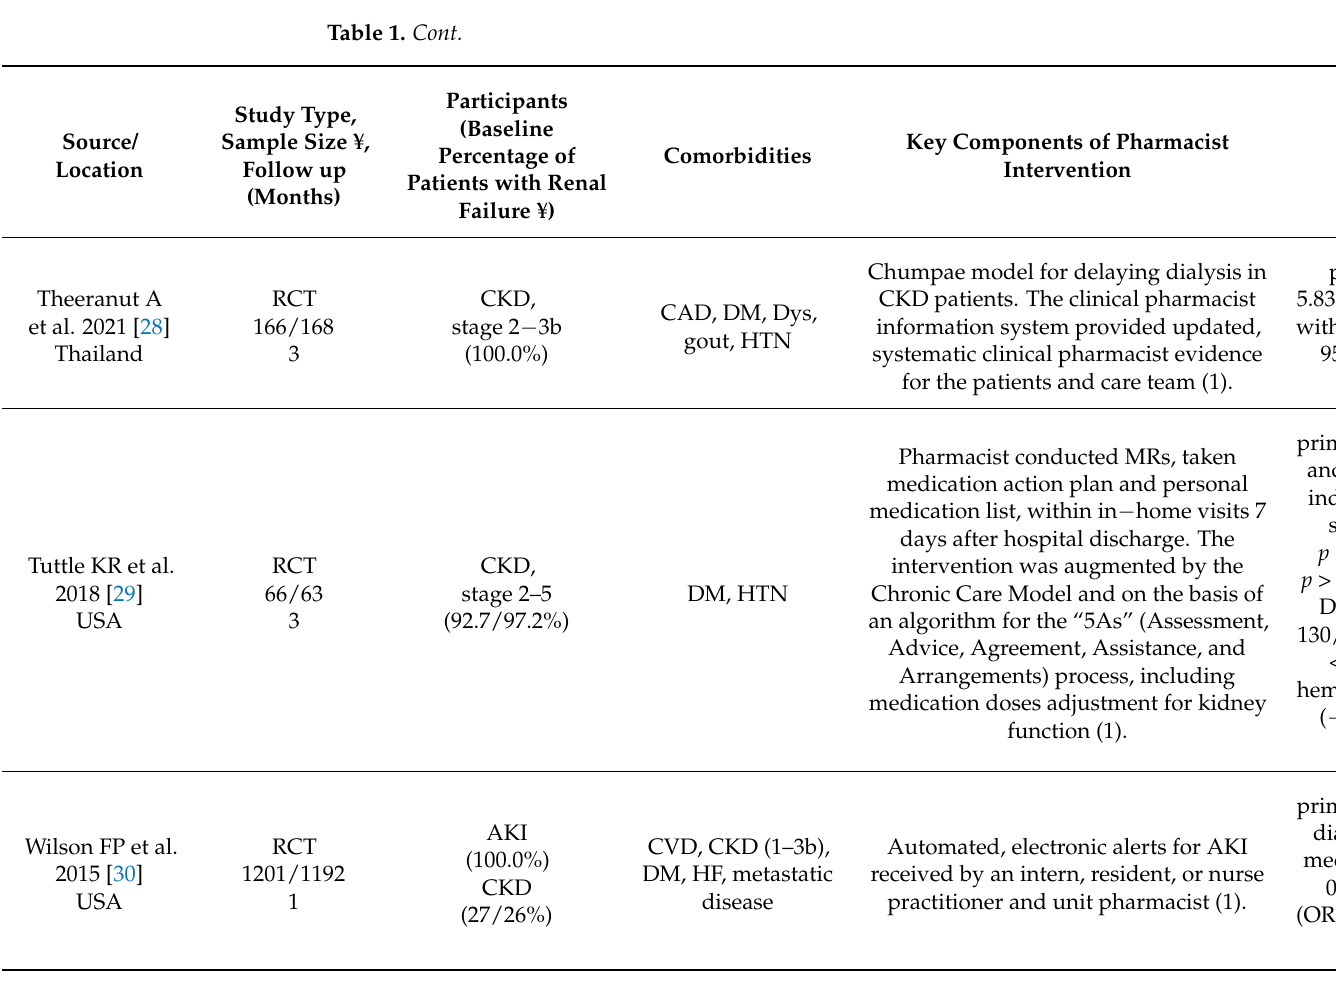
Key Components of Pharmacist Intervention